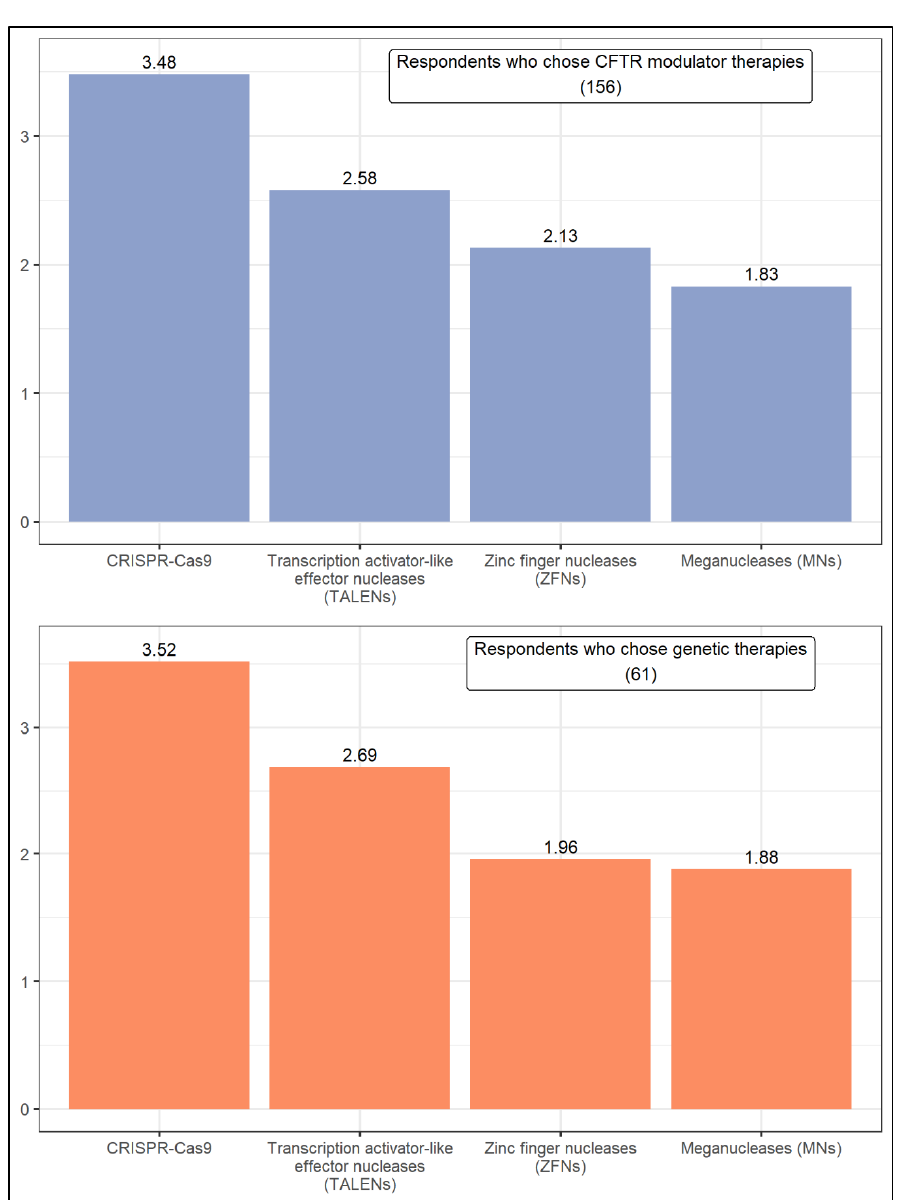
Figure 4. Ranking of approaches aimed at fixing or replacing the malfunctioning CFTR